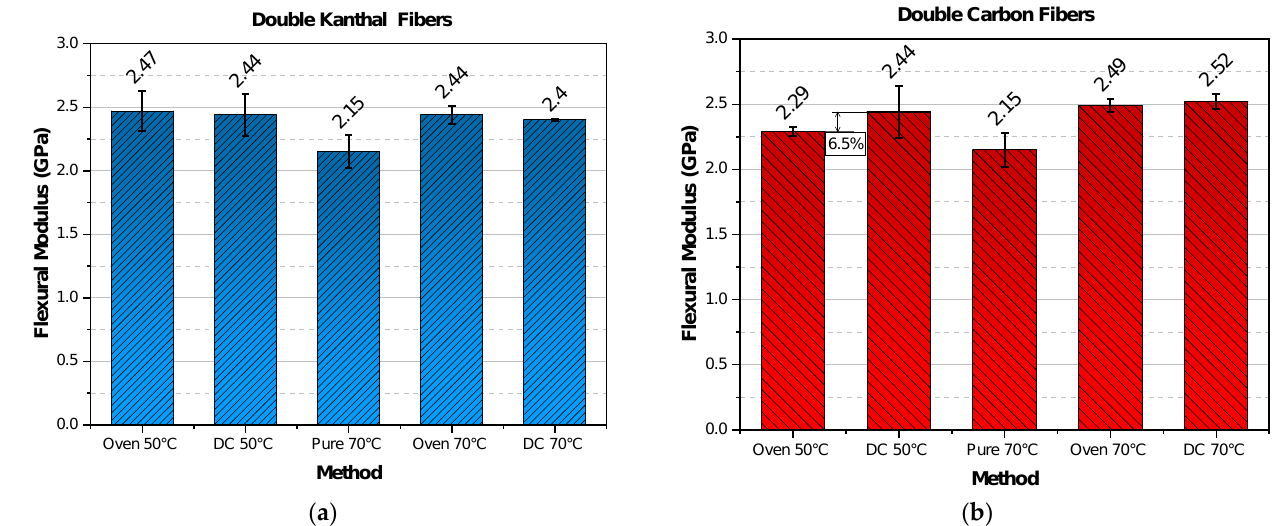
Figure 3. Flexural modulus versus curing method for ( a ) double Kanthal fiber specimens and ( b ) double carbon fiber specimens.